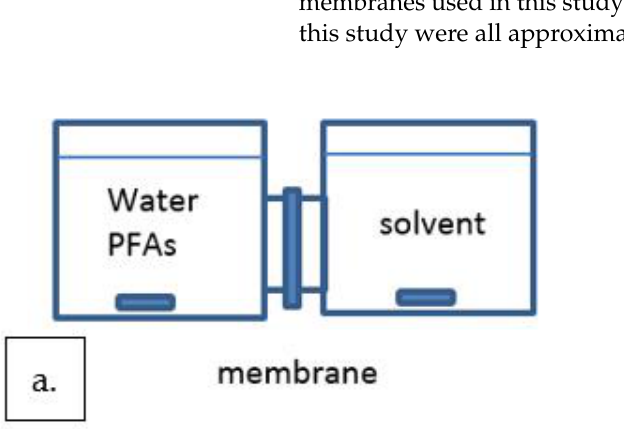
Figure 2. Perstraction test system. ( a ) A schematic of a lab-scale perstraction test system. ( b ) A photo of a perstraction test system used in this study. LHS = left-hand side where the PFOA aqueous solution was placed. RHS = right-hand side where the solvent was placed. The volume on each side of the membrane was 100 cm 3 .